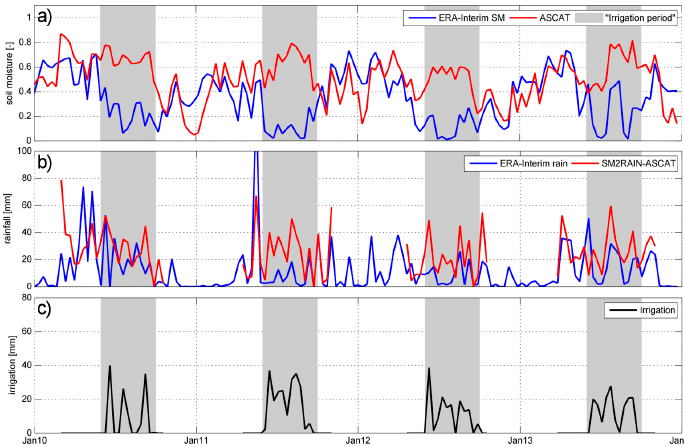
Figure 6. Soil moisture and rainfall time series for a pixel in Nebraska (Longitude, Latitude = − 98 E, 40 N). ( a ) Temporal evolution of ASCAT and ERA ‐ Interim soil moisture, SM, data (10 ‐ day moving average). Grey areas represent the months during which irrigation takes place; ( b ) Temporal evolution of ERA ‐ Interim and SM2RAIN ‐ ASCAT rainfall (10 ‐ day accumulations); ( c ) Temporal evolution of irrigation obtained as the difference between SM2RAIN ‐ ASCAT and ERA ‐ Interim rainfall (10 ‐ day accumulations).